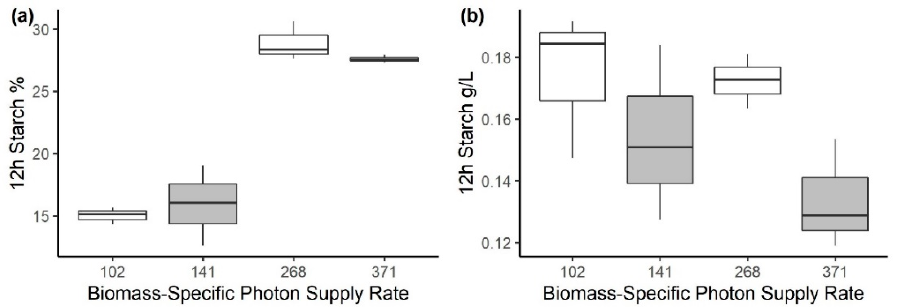
Figure 5. Starch maximum accumulation in C. vulgaris at different biomass specific photon supply rates in experiment 2. ( a ) peak of maximum concentration in the biomass, observed 12 h within starvation; ( b ) peak of maximum starch production in the culture, expressed as g L − 1 , and observed 24 h within starvation.